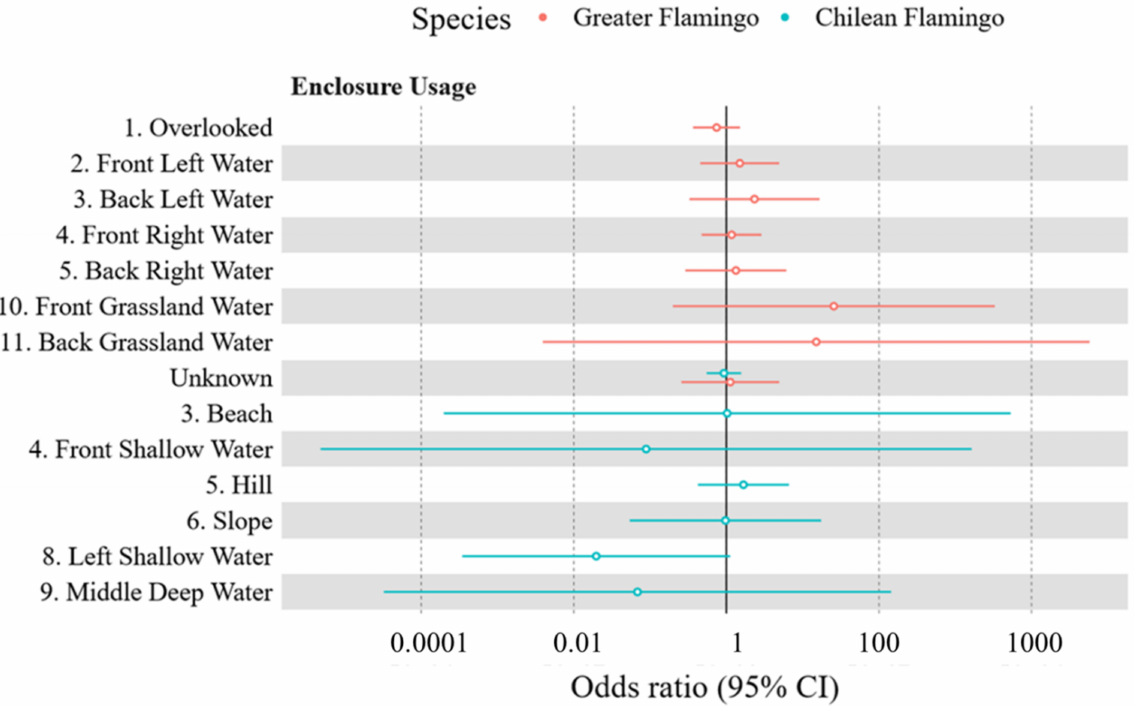
Figure 7. Odds ratios and 95% confidence intervals of the Greater and Chilean Flamingo flock to occupy zones of their enclosure when the zoos were open, compared to when the zoos were closed. Intercept: zoo closed. Hollow points: p ≥ 0.05; filled points: p < 0.05. The odds of both flocks to occupy zones of their respective enclosures did not differ between zoo closed and zoo open